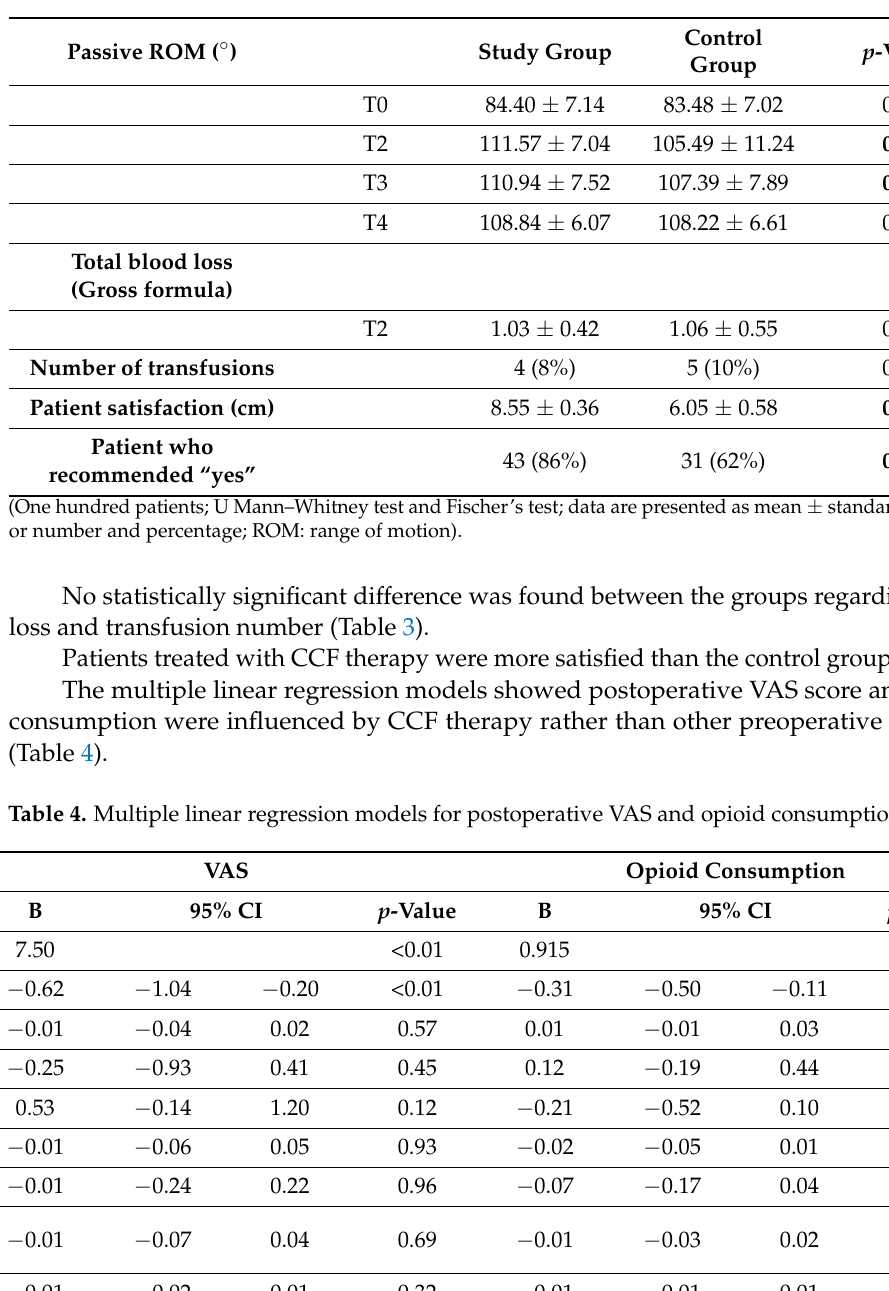
Table 3. Differences in passive range of motion, total blood loss using Gross formula and patient satisfaction between groups.